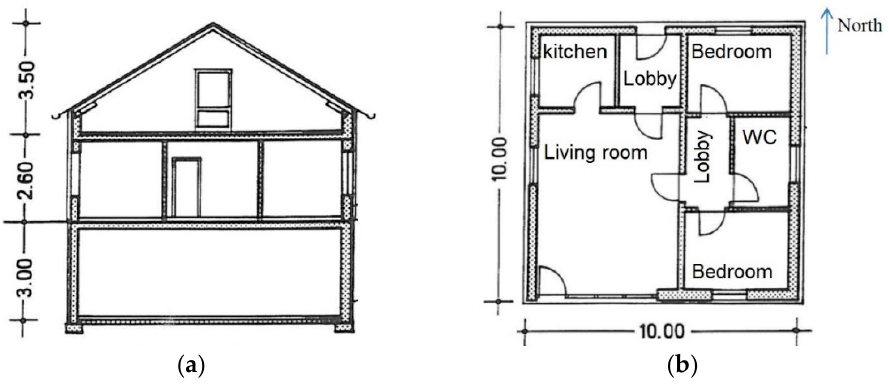
Figure 5. Twin house [28]: ( a ) cross ‐ section; ( b ) ground floor plan.